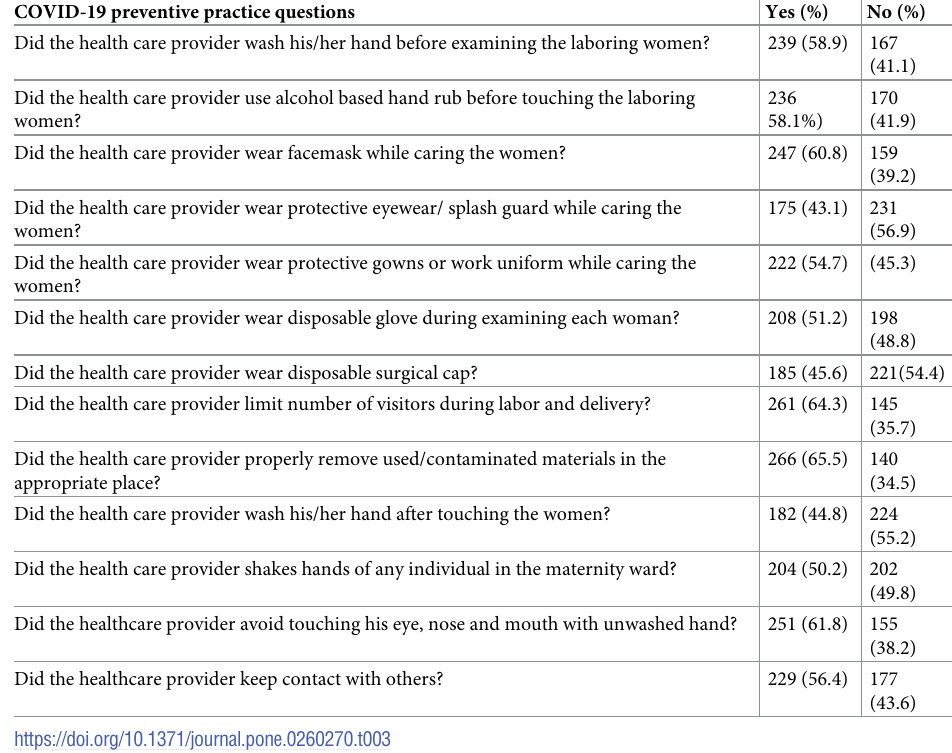
Table 3. Healthcare provider’s adherence to COVID-19 preventive practices during intrapartum care provision in hospitals of Gondar province, northwest Ethiopia, 2020/2021 (n = 406). COVID-19 preventive practice